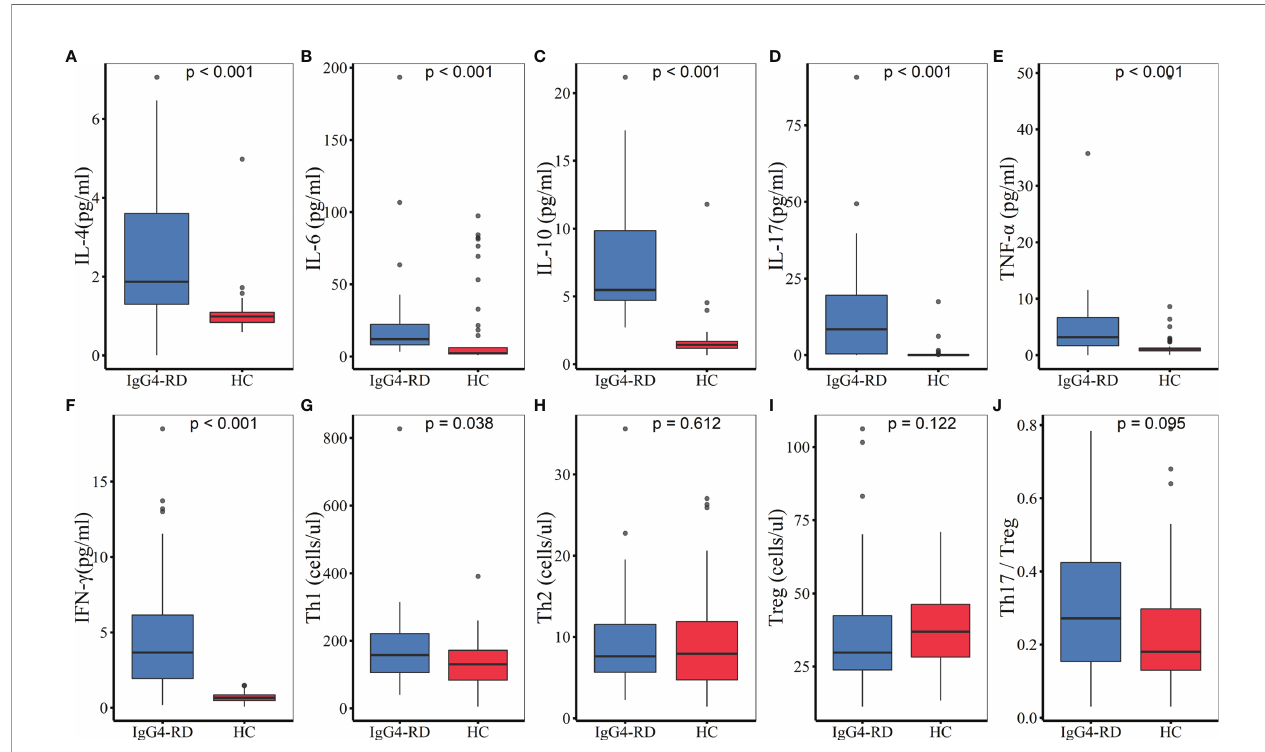
FIGURE 1 | Comparisons of serum cytokines and CD4 + T cell subsets between IgG4-RD patients and HC. (A – F) The levels of serum IL-4, IL-6, IL-10, IL-17, TNF- a , and IFN- g were higher in patients with IgG4-RD compared to HC (P < 0.001). (G) The absolute Th1 counts were higher in IgG4-RD patients than in HC (P < 0.05). (H – J) There was no signi fi cant difference in the absolute counts of Th2 and Treg cells, as well as Th17/Treg ratio between IgG4-RD patients and HC. HC, healthy